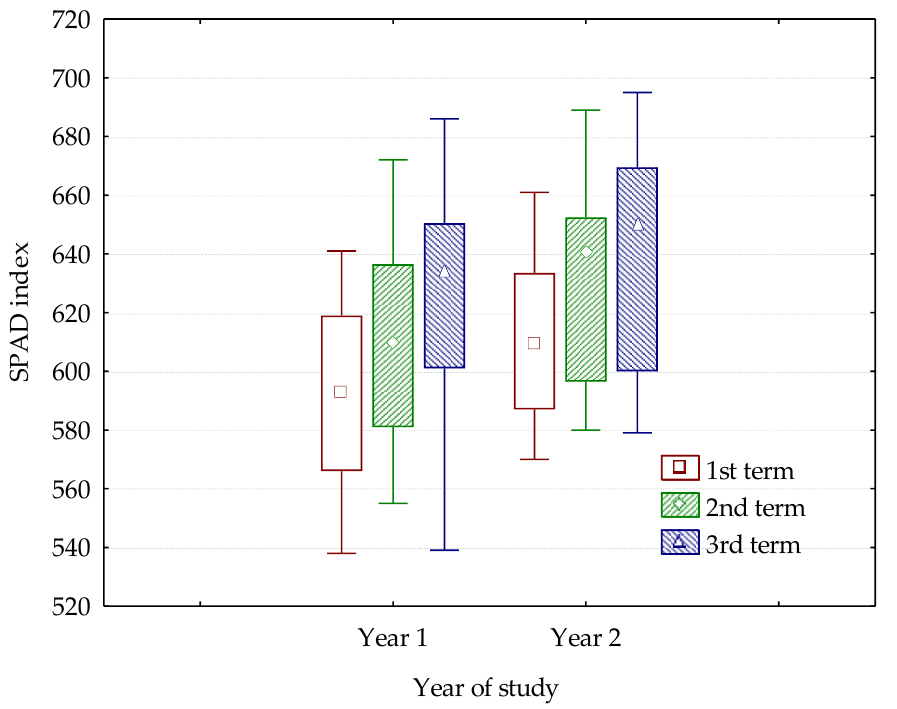
Figure 1. Boxplot of the SPAD index of two maize varieties in two years of the study (mean from fertilization treatments). The growth dynamics of the leaf greenness index from the day of plant emergence